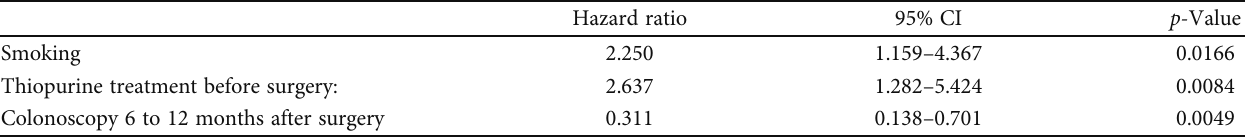
Table 3: Predictive factors of postoperative surgical recurrence multivariate analysis in the entire cohort.